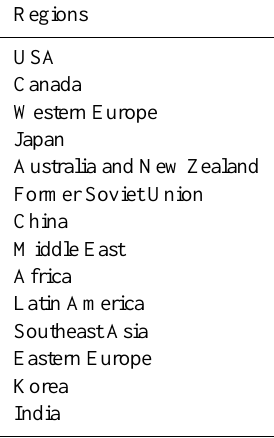
Ecosystem Types Boreal